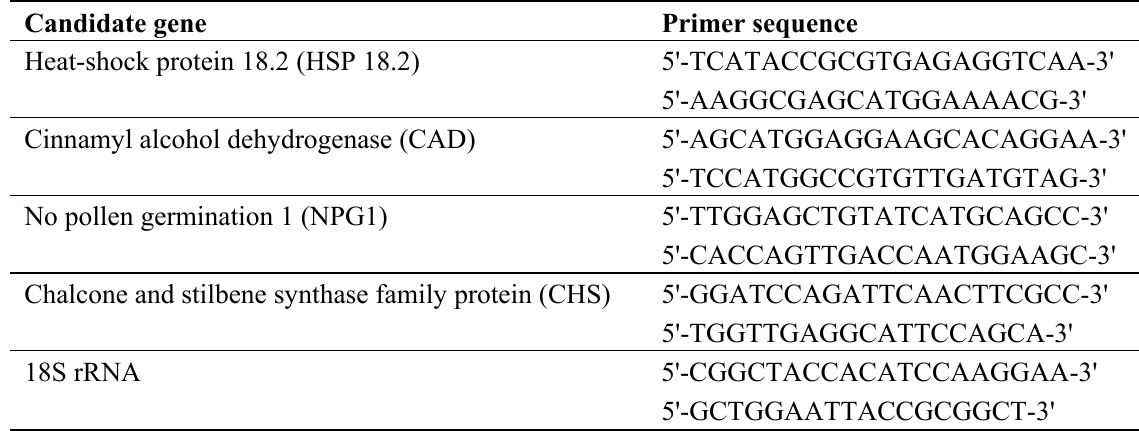
Table 3. Primer sequences for quantitative real-time PCR